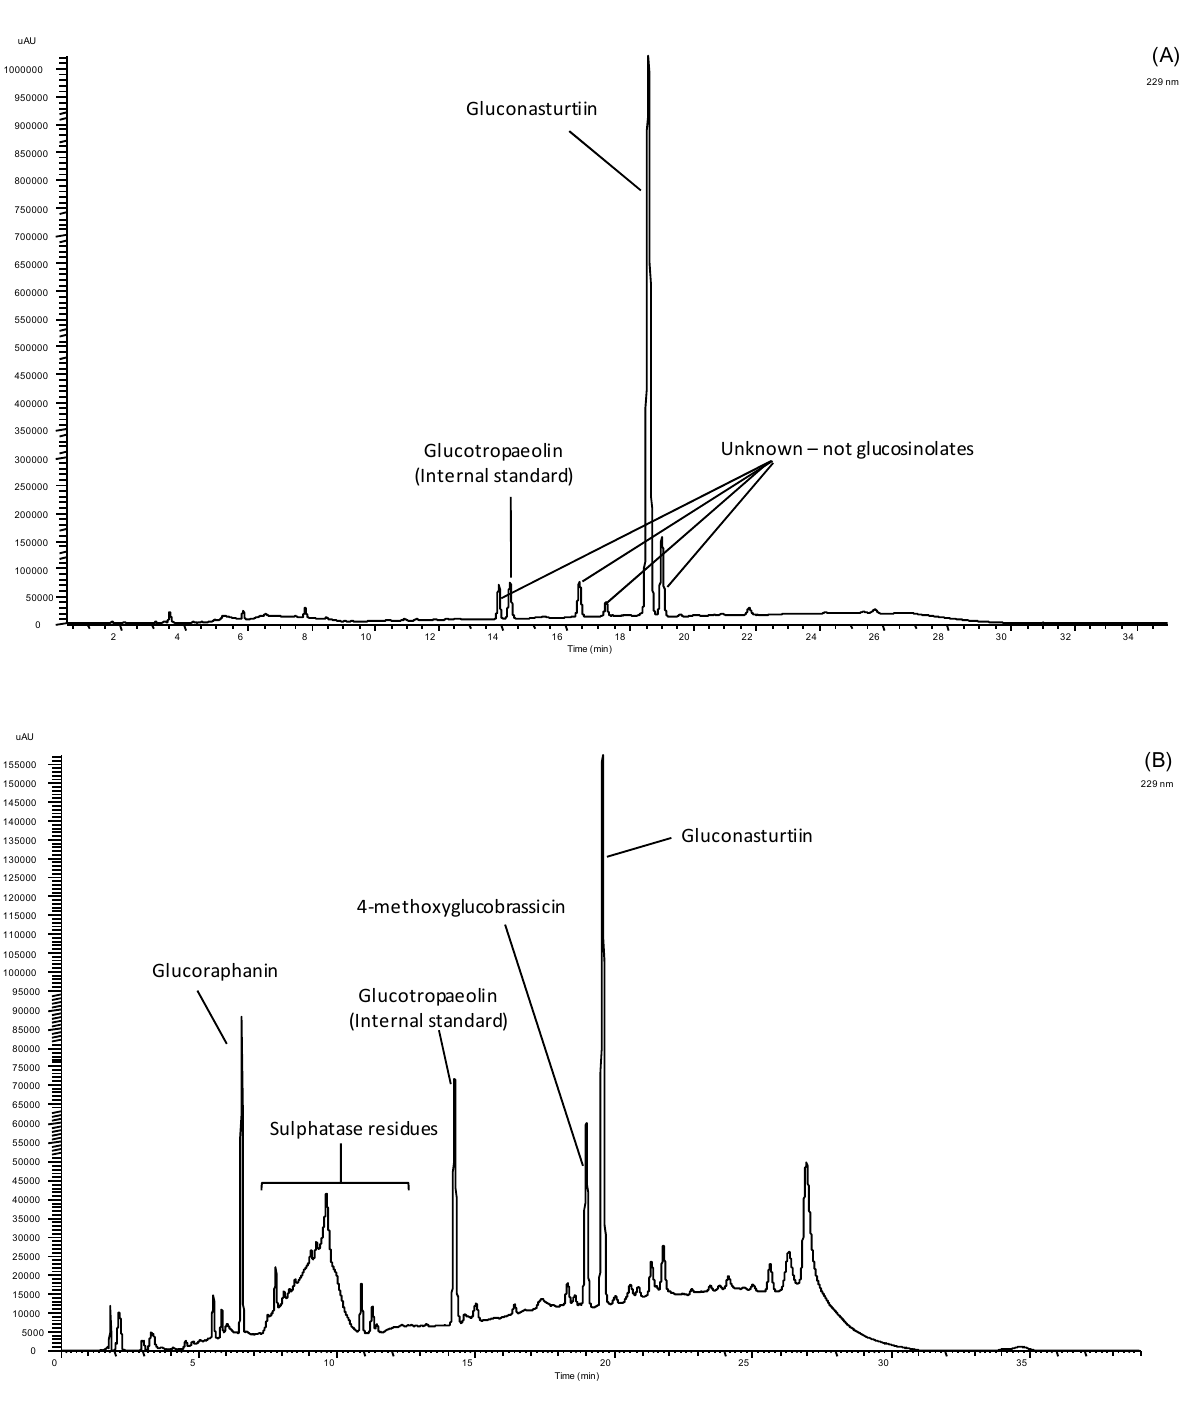
Figure 2. HPLC chromatogram of glucosinolates detected in a watercress ( A ) and rucola ( B ) baby-leaf extract recorded at 229